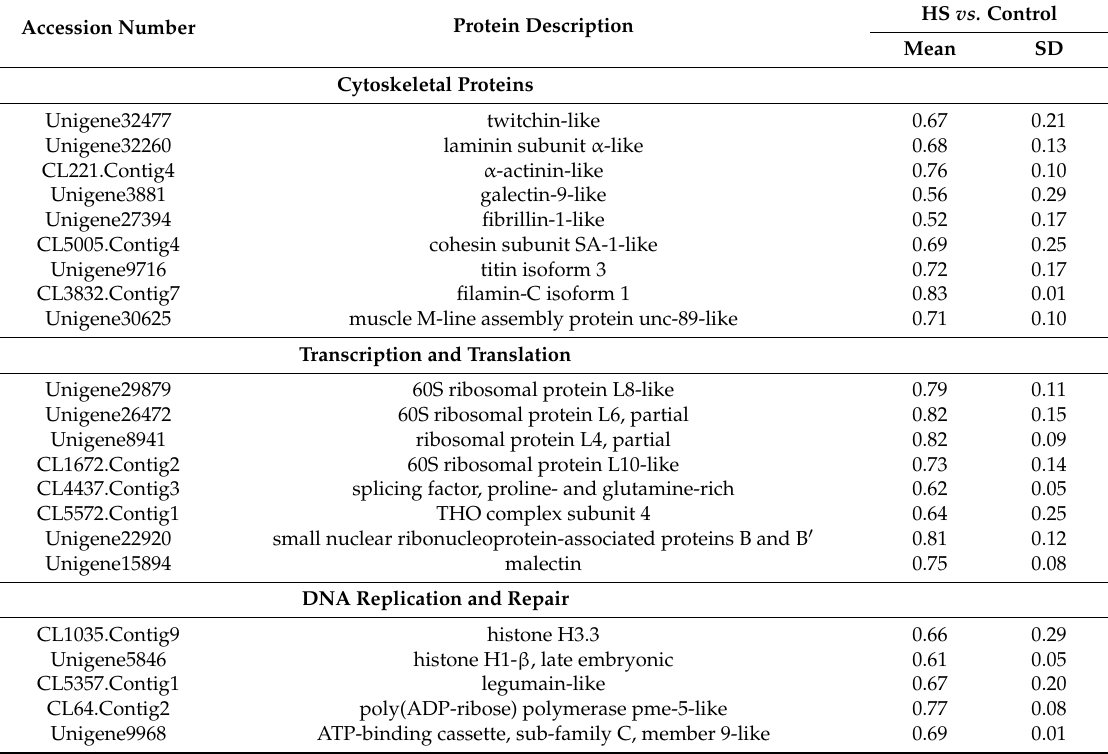
Table 3. Sixty-six downregulated proteins under heat stress in the intestine of the sea cucumber A. japonicas